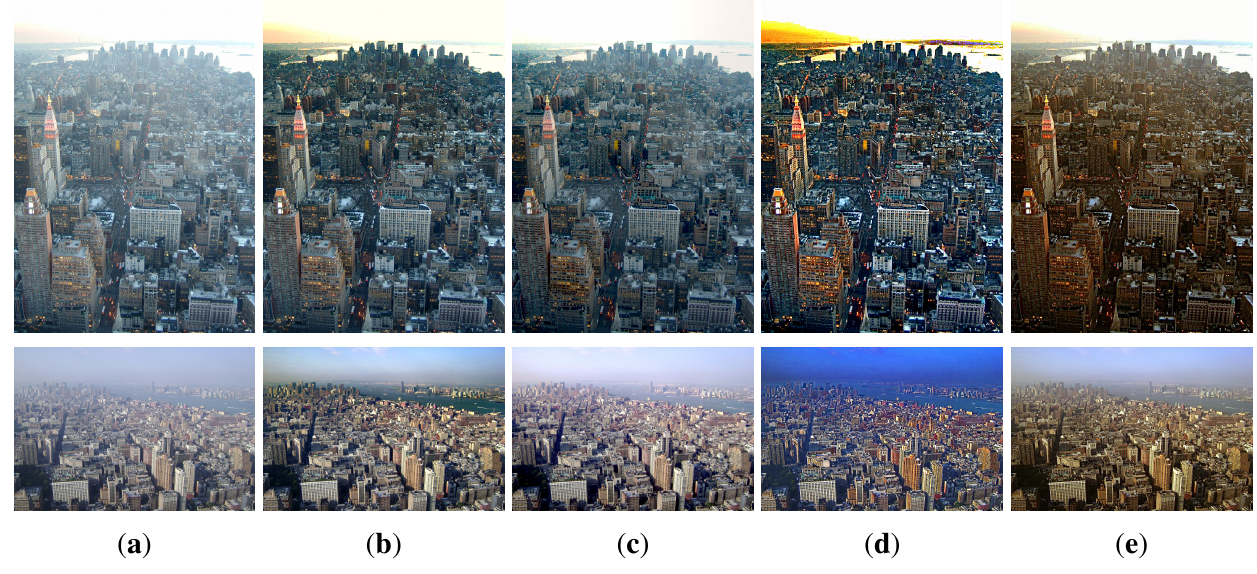
Experimental results of various dehazing methods: ( a ) input hazy